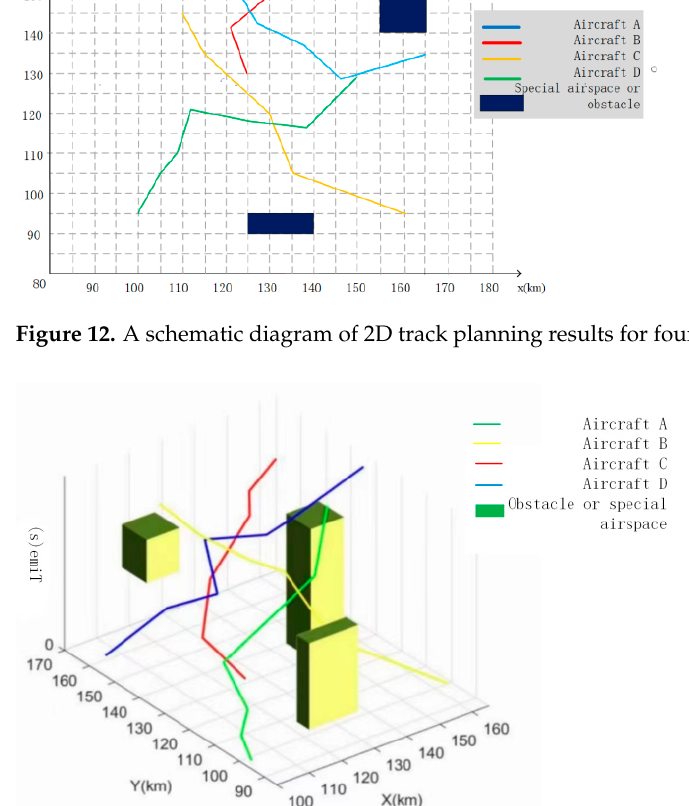
Figure 13. Schematic diagram of 3D track planning results for four aircrafts. obtained 2D and 3D track maps are shown in Figures 14 and 15.